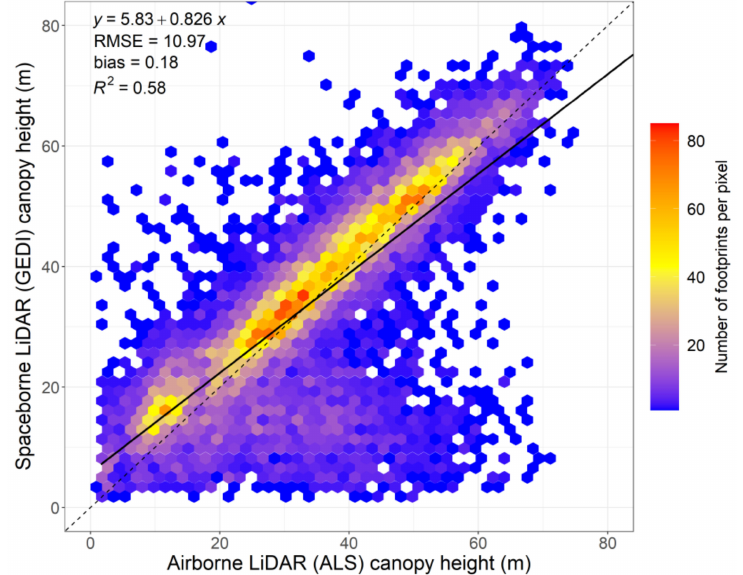
Figure 5. Scatter plot of ALS and GEDI canopy height values (RH 95 or 95th percentile of cumulative return energy) for all individual footprints (11,832). The 1:1 line is shown (dashed); the color of the pixel (legend) represents the number of footprints having a common value of canopy height.